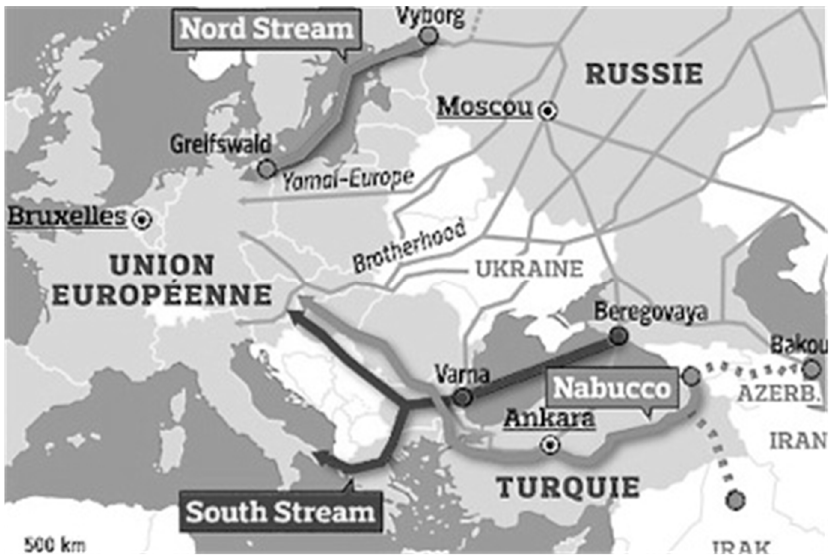
Figure 14. Connection of Nord Stream and the Nabucco and South Stream projects [76].